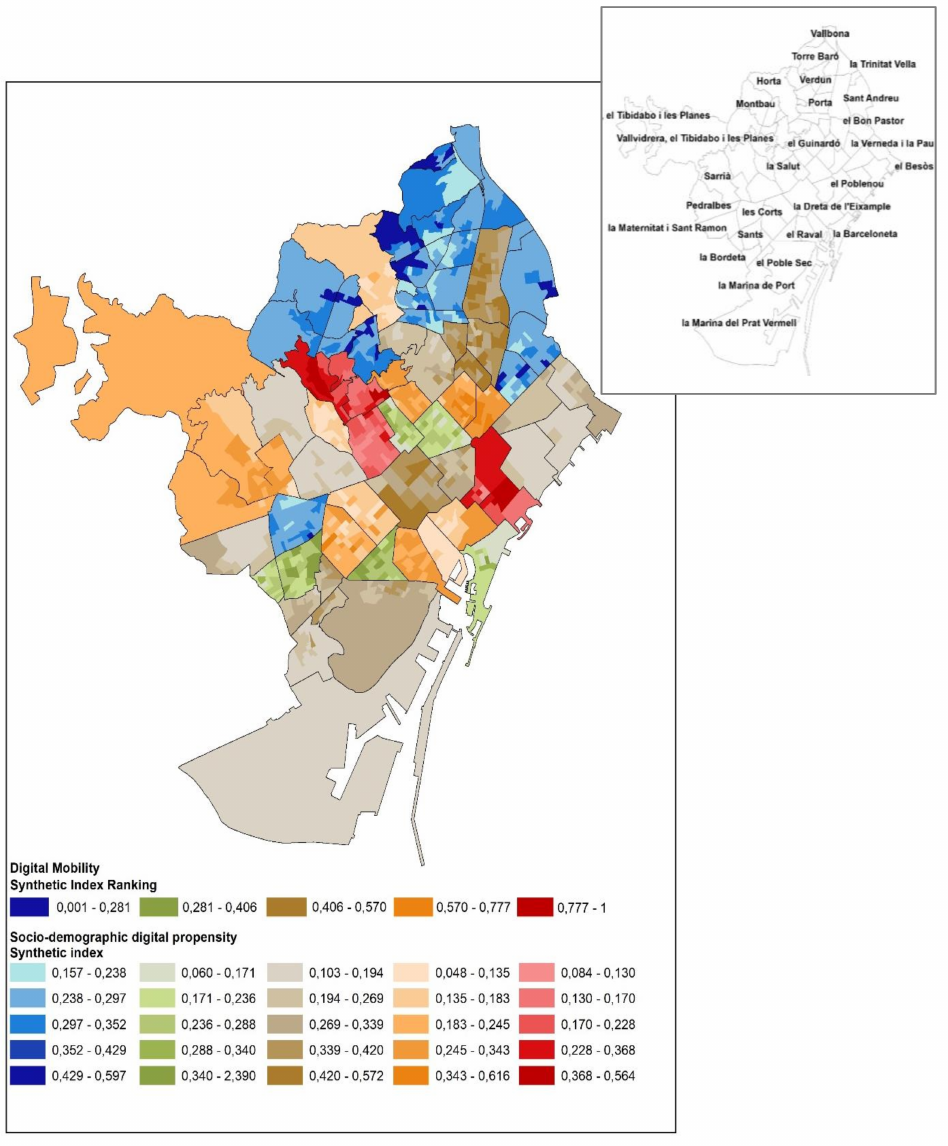
Figure 2. Digital Mobility Index and Socio-Demographic Digital Propensity, Barcelona